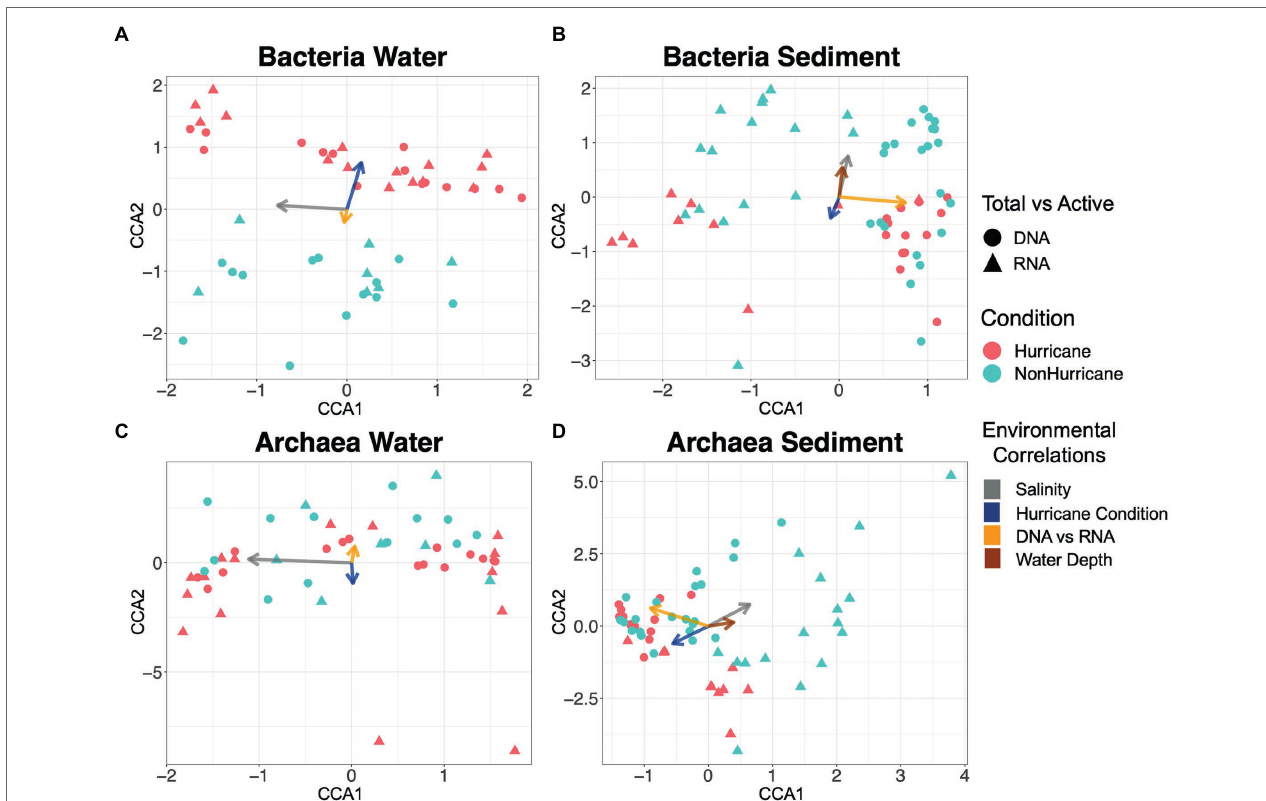
FIGURE 3 | Canonical Correspondence Analysis plots showing similarities in microbial community composition across samples. Each data point is one sample, and distance between points represent degree of similarity in community composition. Arrows represent influence from environmental variables, and length of arrow represents strength of correlation. (A) Hurricane conditions led to significant differences within surface water bacterial communities compared to non-hurricane conditions (ANOSIM test: R = 0.185, p < 0.001), with community composition significantly correlated with salinity and putative cell activity (PERMANOVA test: Salinity: R 2 = 0.357, p < 0.05; Hurricane conditions: R 2 = 0.105, p < 0.05; DNA vs. RNA: R 2 = 0.102, p < 0.05); (B) Bacterial sediment communities were most strongly correlated with putative cell activity, followed by salinity and water depth (DNA vs. RNA: R 2 = 0.31, p < 0.05; Salinity: R 2 = 0.059, p < 0.05; Water depth: R 2 = 0.043, p < 0.05); (C) Archaeal surface water communities were correlated only with salinity ( R 2 = 0.377, p < 0.05); and (D) Archaeal sediment communities were most strongly controlled by putative cell activity, followed by salinity and water depth (DNA vs. RNA: R 2 = 0.305, p < 0.05; Salinity: R 2 = 0.152, p < 0.05; Water depth: R 2 = 0.060, p <